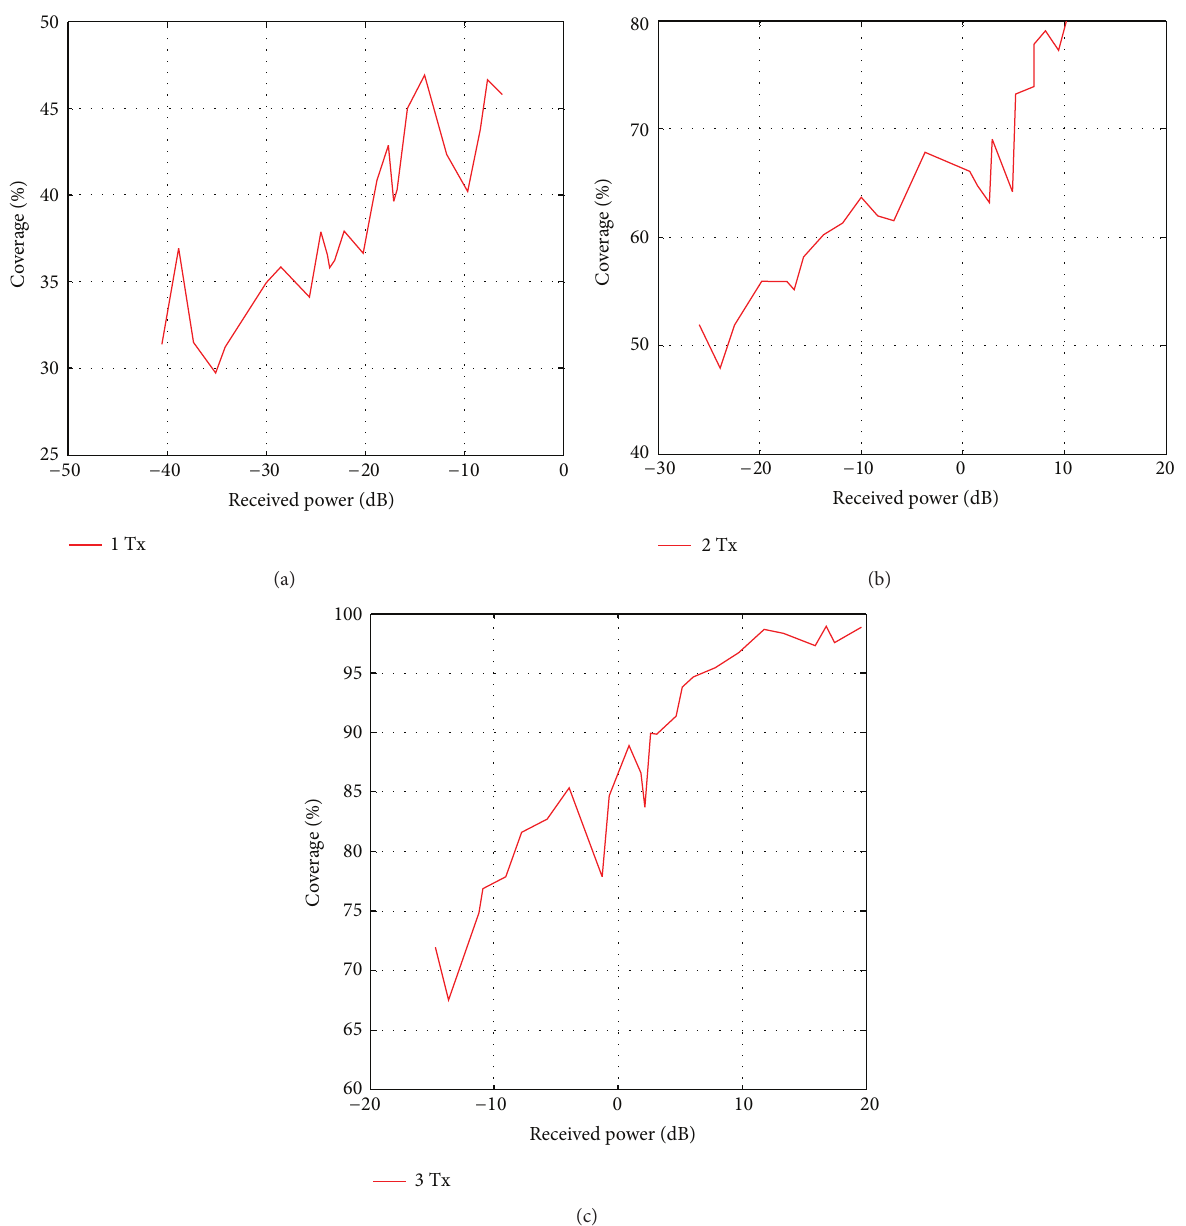
Figure 8: Received power versus coverage with (a) 1 Tx, (b) 2 Tx, and (c) 3